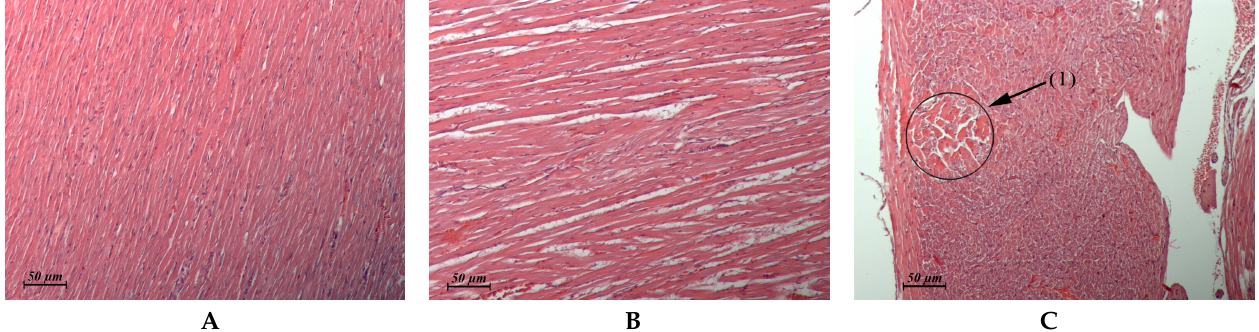
Figure 4. ( A – C ) Rat myocardium. ( A ) Untreated control. ( B ) Flavancin, 15 × 10 mg/kg/day, 1 day post-treatment. Interstitial edema. ( C ) Flavancin, 15 × 10 mg/kg/day, 1 day post-treatment. Focus of interstitial edema associated with toxic cardiomyopathy (1) ×